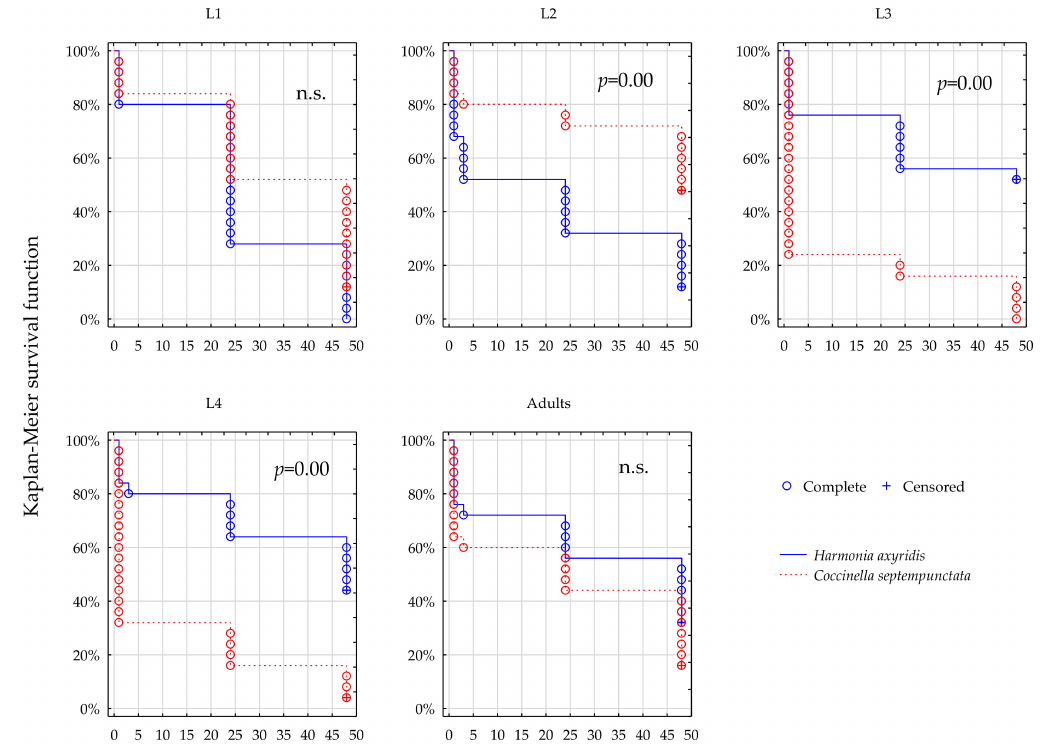
Figure 3. Survival dynamics of larvae and adults of the two predators after foraging on the prey treated with Calypso at 100% recommended field rate.